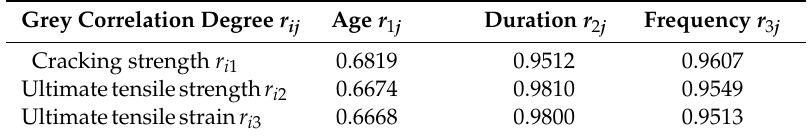
Table 6. Grey correlation degrees of the vibration factors on the tensile performance of PVA-ECC.